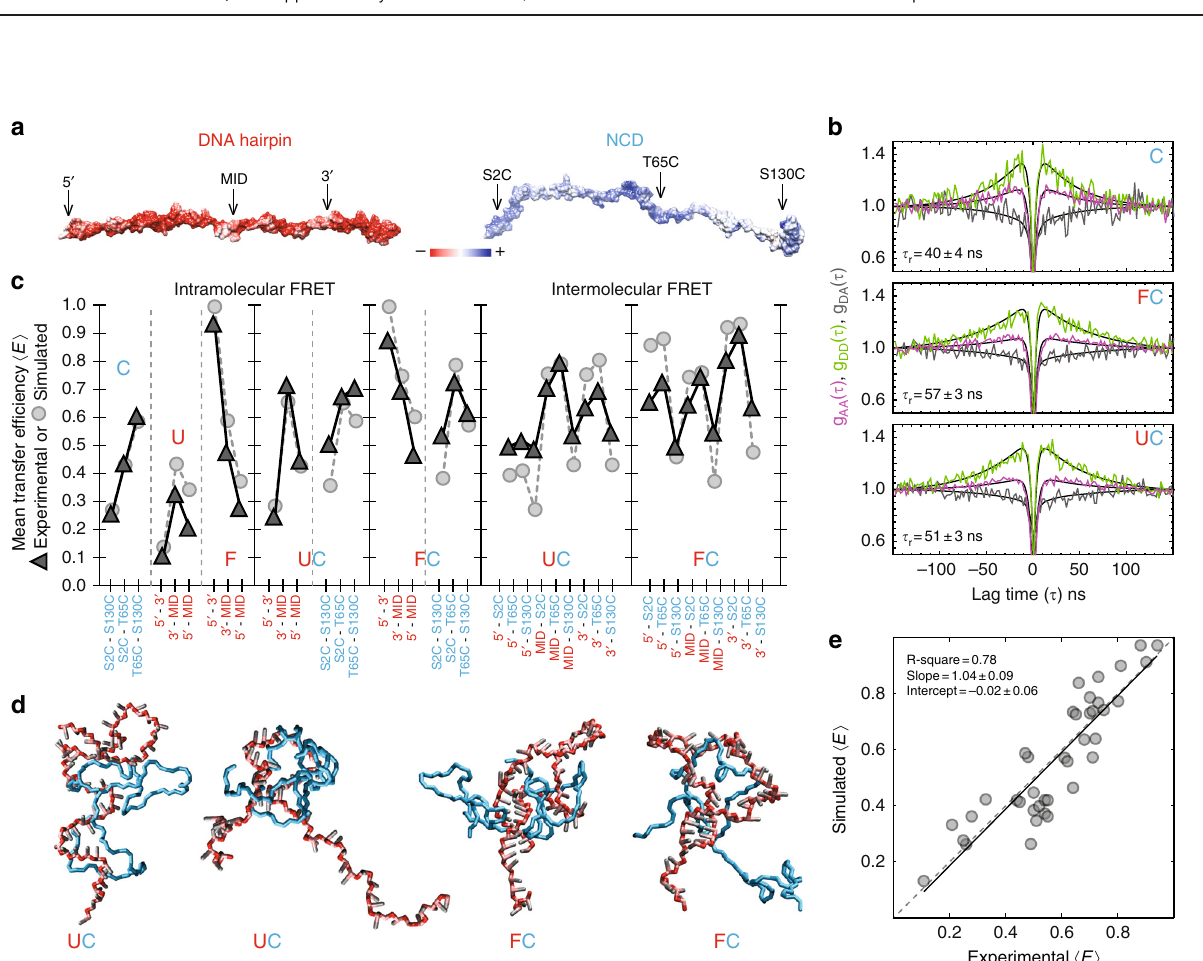
Fig. 2 Chaperone binding accelerates hairpin folding. a Representative donor (green) and acceptor (magenta) fl uorescence time traces depicting unassisted folding of the surface-immobilized 5 ′ -3 ′ FRET-labeled hairpin. The uncorrected transfer ef fi ciency, ^ E , (black) and the most likely state trajectory (gray) based on the Viterbi algorithm are shown below. b Analogous to a , but depicting chaperone-assisted hairpin folding with saturating concentrations of NCD (150 nM) to ensure that hairpin molecules are almost always chaperone-associated. c Survival probability plots of folded- (upper left) and unfolded-state (lower left) dwell times in the absence of chaperone, fi t with single-exponential decays to determine the unfolding and folding rate constants, k U and k F , respectively; 〈 k U 〉 and 〈 k F 〉 represent mean values obtained from 54 single-molecule measurements. The donor-acceptor fl uorescence cross-correlation function (right) decorrelates with a rate constant that is consistent with the sum of k U and k F from the dwell-time analysis. d Analogous to c , but for chaperone-assisted folding; 〈 k U 〉 and 〈 k F 〉 represent mean values obtained from 26 single-molecule measurements. The black lines in c and d are fi ts with single exponentials with 99% con fi dence bands shown in gray. e Representative fl uorescence time trace measured at a chaperone concentration near app K d . Transitions between chaperone-bound (cyan shading) and chaperone-free (red shading) kinetic regimes arise from binding and dissociation of NCD. f Kinetic 4-state model for chaperone-assisted folding. The folded, F, and unfolded, U, conformations of the hairpin freely interconvert in the absence of chaperone, C, with an equilibrium constant that favors U. When the chaperone is bound, the unfolded, UC, and folded, FC, conformations of the hairpin still interconvert, but with an equilibrium constant that favors F. g Trajectory from coarse-grained molecular dynamics simulation showing binding (cyan shading) and dissociation (red shading) of the chaperone to the hairpin concomitant with the formation of intermolecular contacts (gray). The folding and unfolding of the hairpin, monitored via native contacts (black), is shifted to favor hairpin formation when the chaperone is bound. Structural representations are taken from the simulations (see Supplementary Movies 1 and 2). Source data for mean values in c and d are provided as a Source Data File